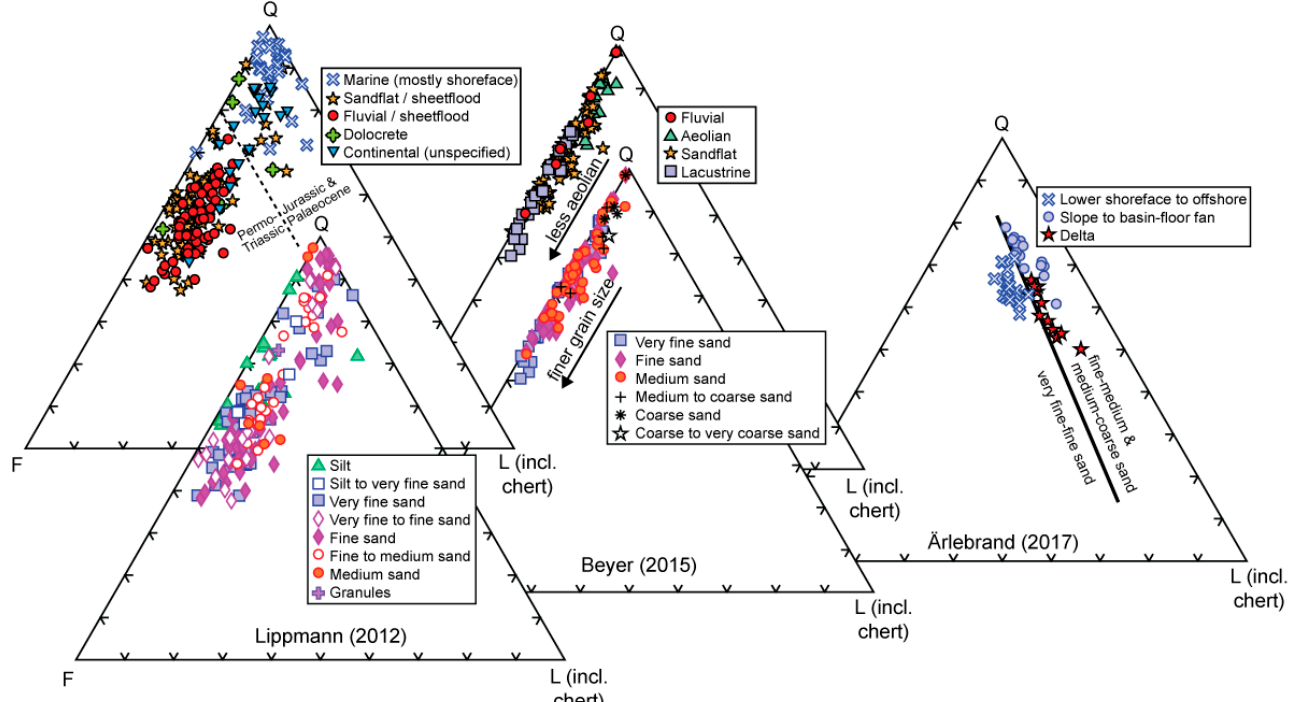
Figure 7. Grain-size sorting in relation to facies in Gazzi–Dickinson-based compositional diagrams that exclude carbonate clasts. The data of Ärlebrand [40] were counted using the Gazzi–Dickinson method but with a 20 µm grain-matrix size limit. Lippmann [36] and Beyer [39] did not mention the used counting method. Few samples with the vague grain-size specification “sand” [36,39] are not plotted in the grain-size figures. F: feldspar; L: lithic/rock fragments; Q: quartz (both monocrystalline and polycrystalline grains).